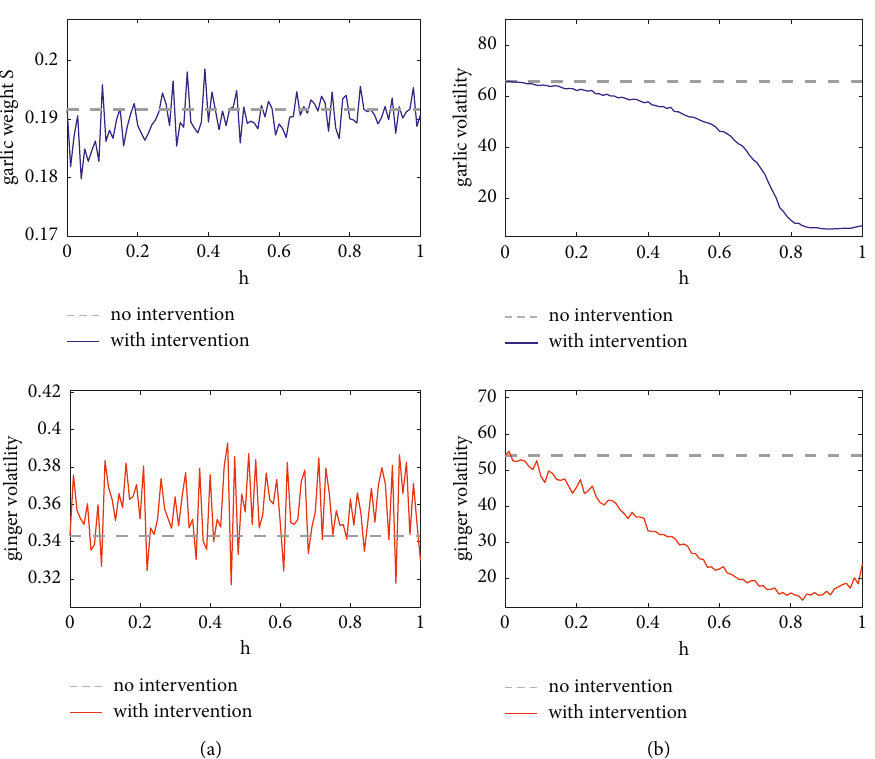
Figure 3: Intervention results of the government-guidance price policy. The figures show the average market fraction of speculators (weight S ) and average price volatilities under different proportions of producers following government-guided price (parameter h ). (a): The average market fraction of speculators is barely affected by the parameter h . (b): More producers following the government-guided price help to reduce price Table 3: Price variance reductions due to intervention under alternative settings. Garlic Ginger Model parameter or P G e,t varies by Model parameter or P G e,t varies by +5% –20%